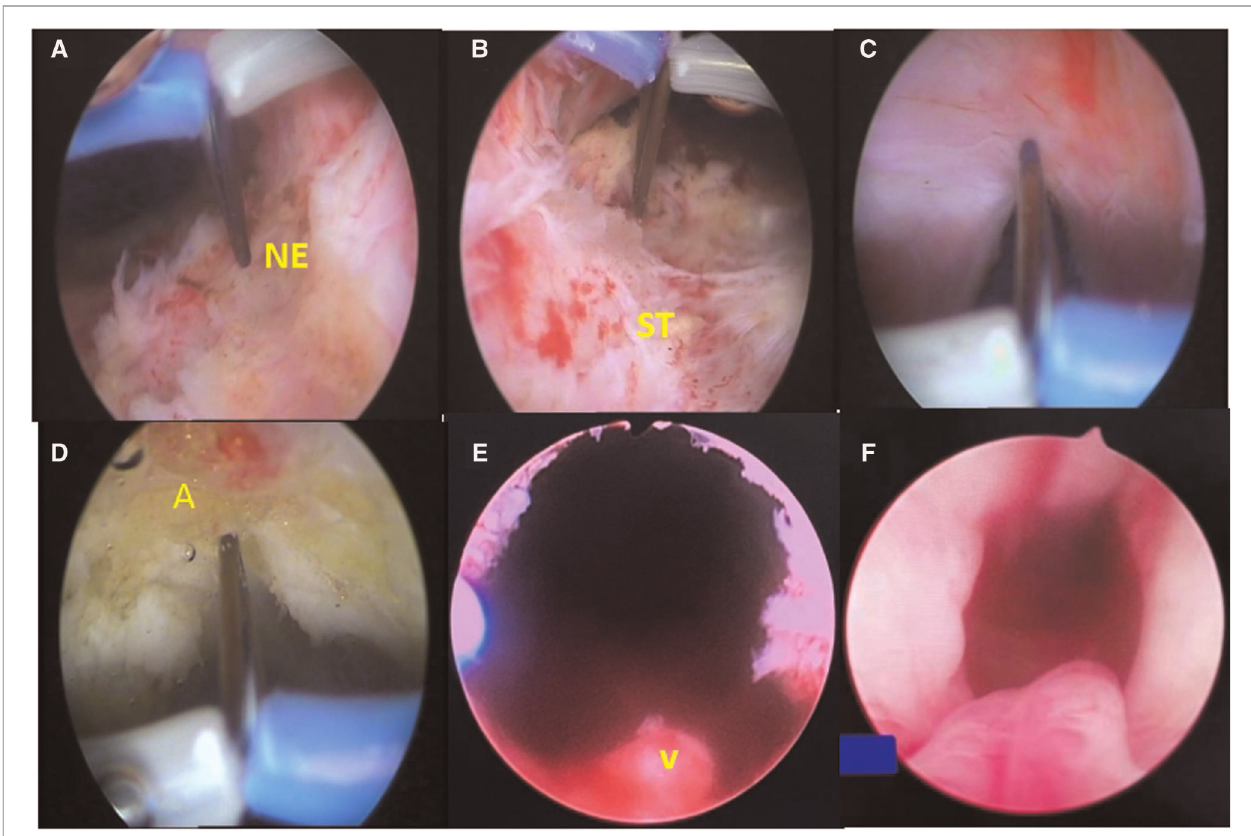
FIGURE 2 | ( A – D ) The incisions were performed at 5, 7, and 12 O ’ clock positions using a needle electrode (NE) to create an incisional pathway from the bladder neck to the proximal verumontanum (V), which reached the adipose layer (A); ( E ) immediate resectoscopic view of the bladder neck after TUIBN; ( F ) cystoscopic view of the bladder neck 1 month after